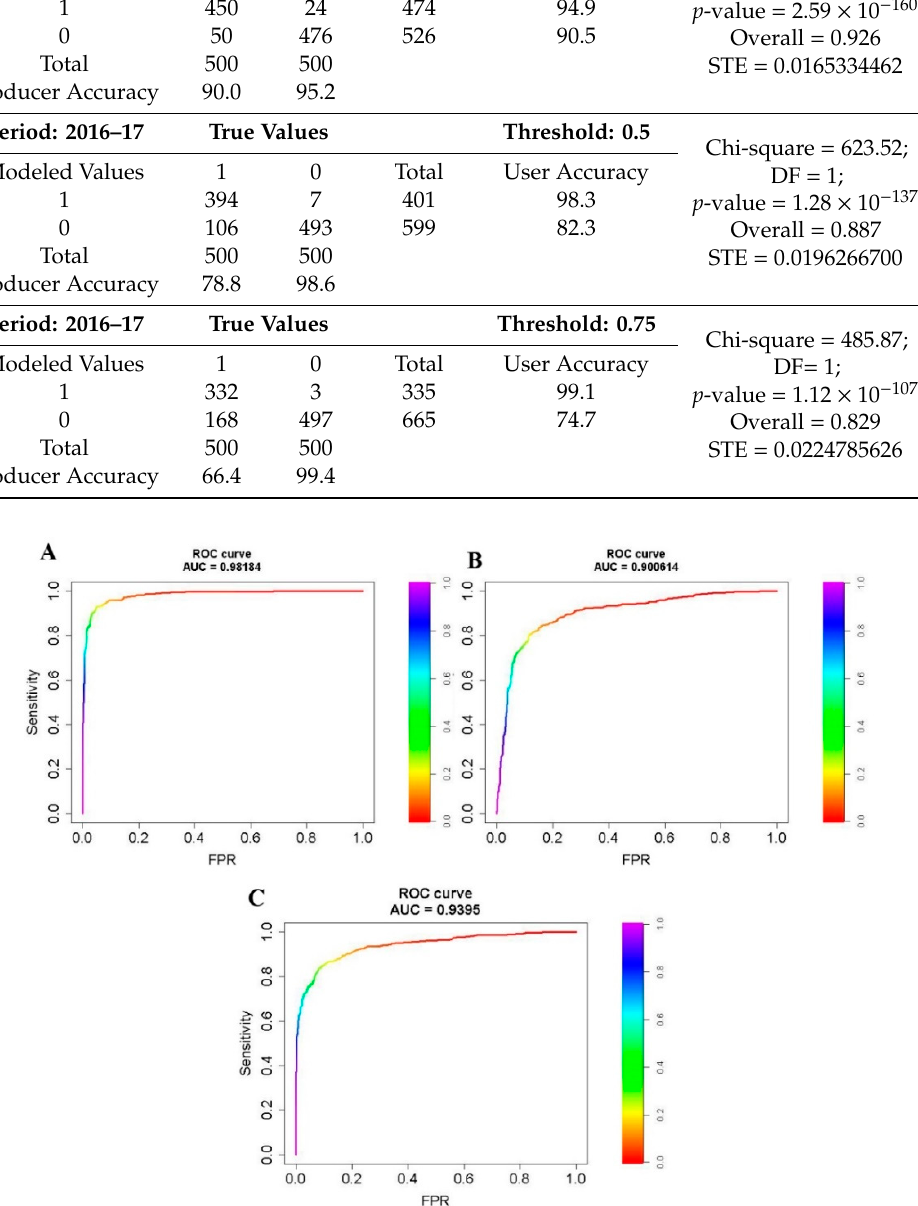
Figure 7. Receiver Operating Characteristics (ROC) curves derived from 1000-observation, independent validation dataset for the periods of: ( A ) 2016–2017; ( B ) 2017–2018; and ( C ) 2018–2019. Area Under Curve (AUC) denotes the overall model accuracy (values closer to 1—higher model accuracy). FPR on x-axis is the False Positive Rate (i.e., 1-specificity).